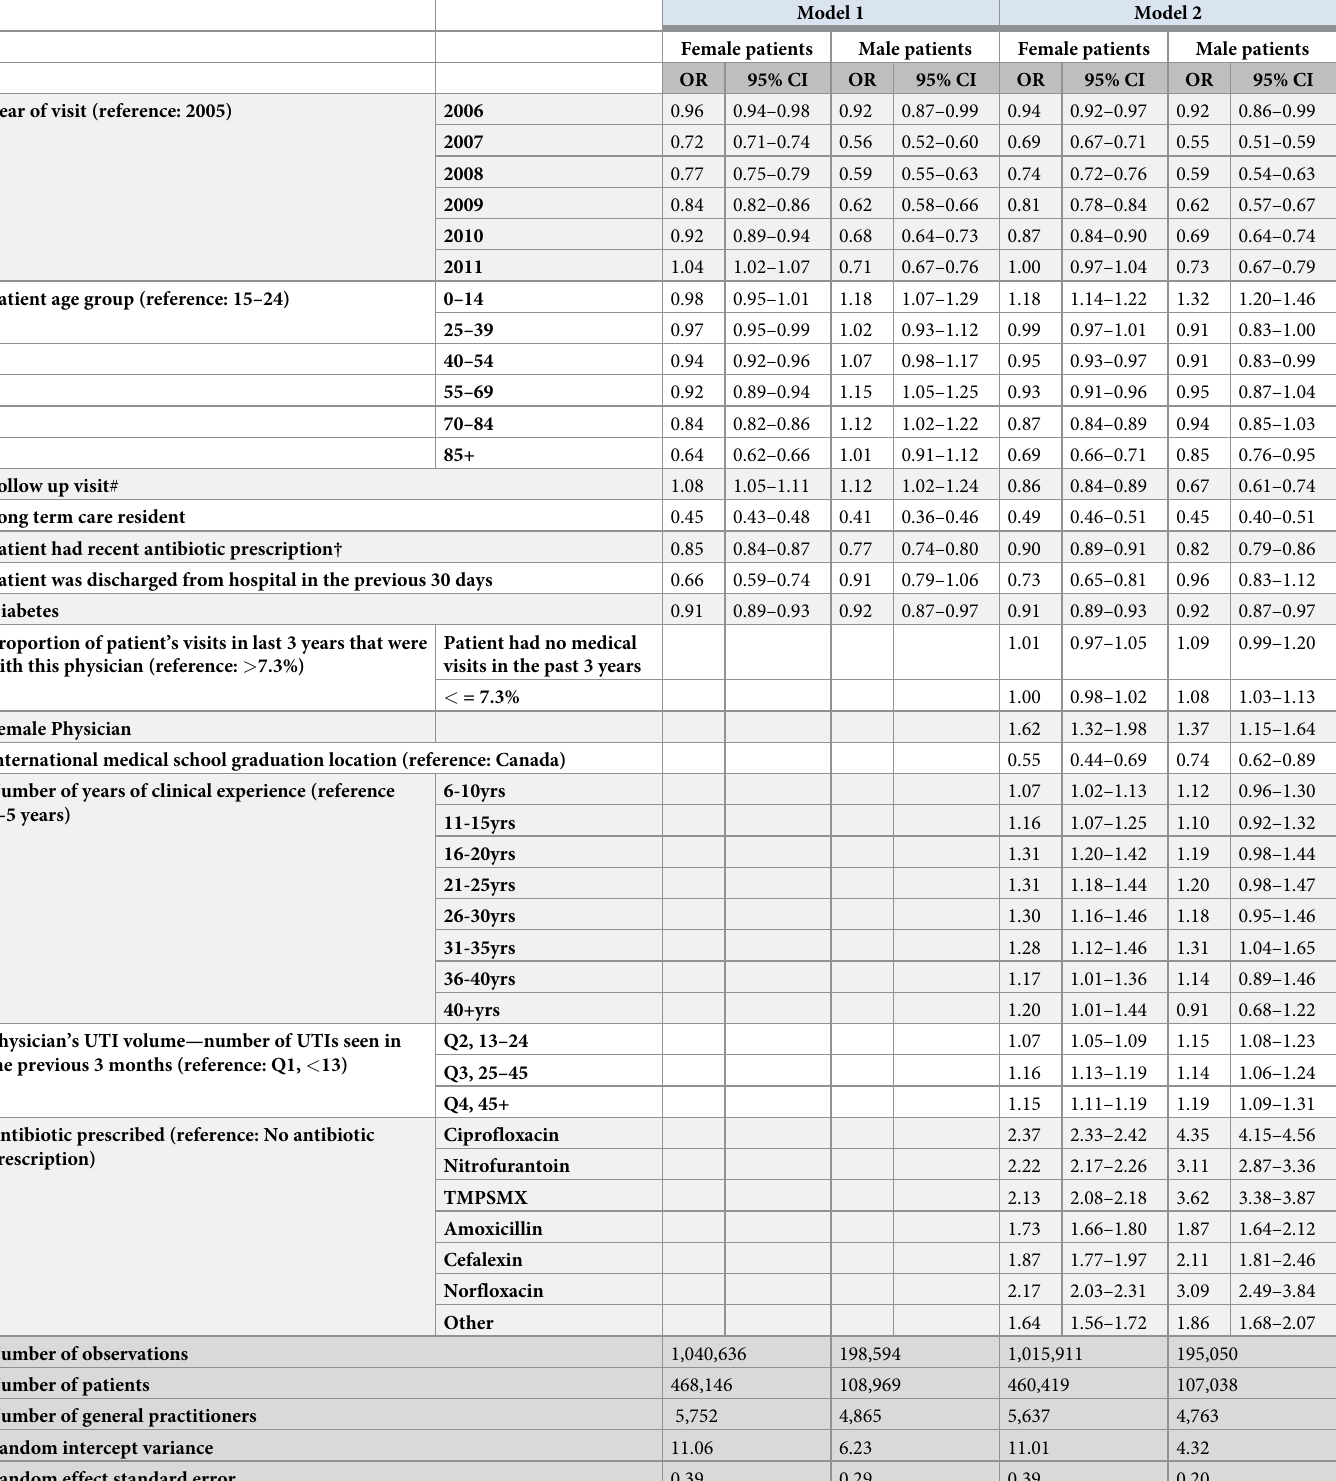
Table 2. Generalized linear mixed models for the odds of urine culture per cystitis visit. Model 1 includes only patient-level covariates, and model 2 includes both patient- and physician-level covariates. Complete case